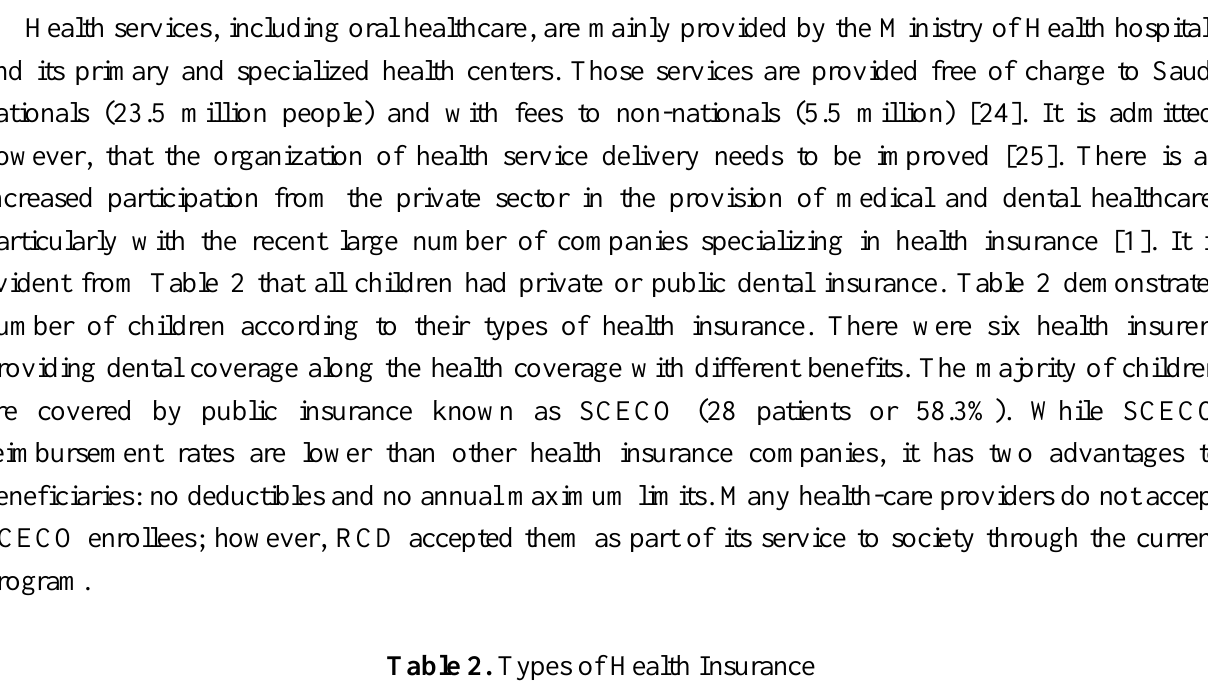
Table 2. Types of Health